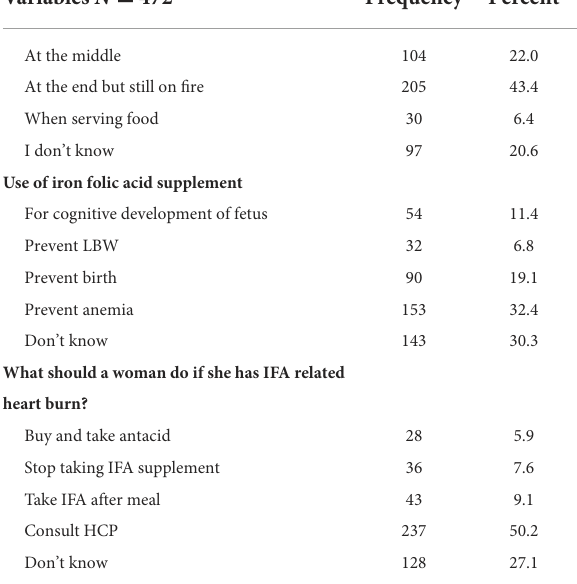
TABLE 4 Knowledge of mothers on source of important nutrients in East Shoa zone, from June to August